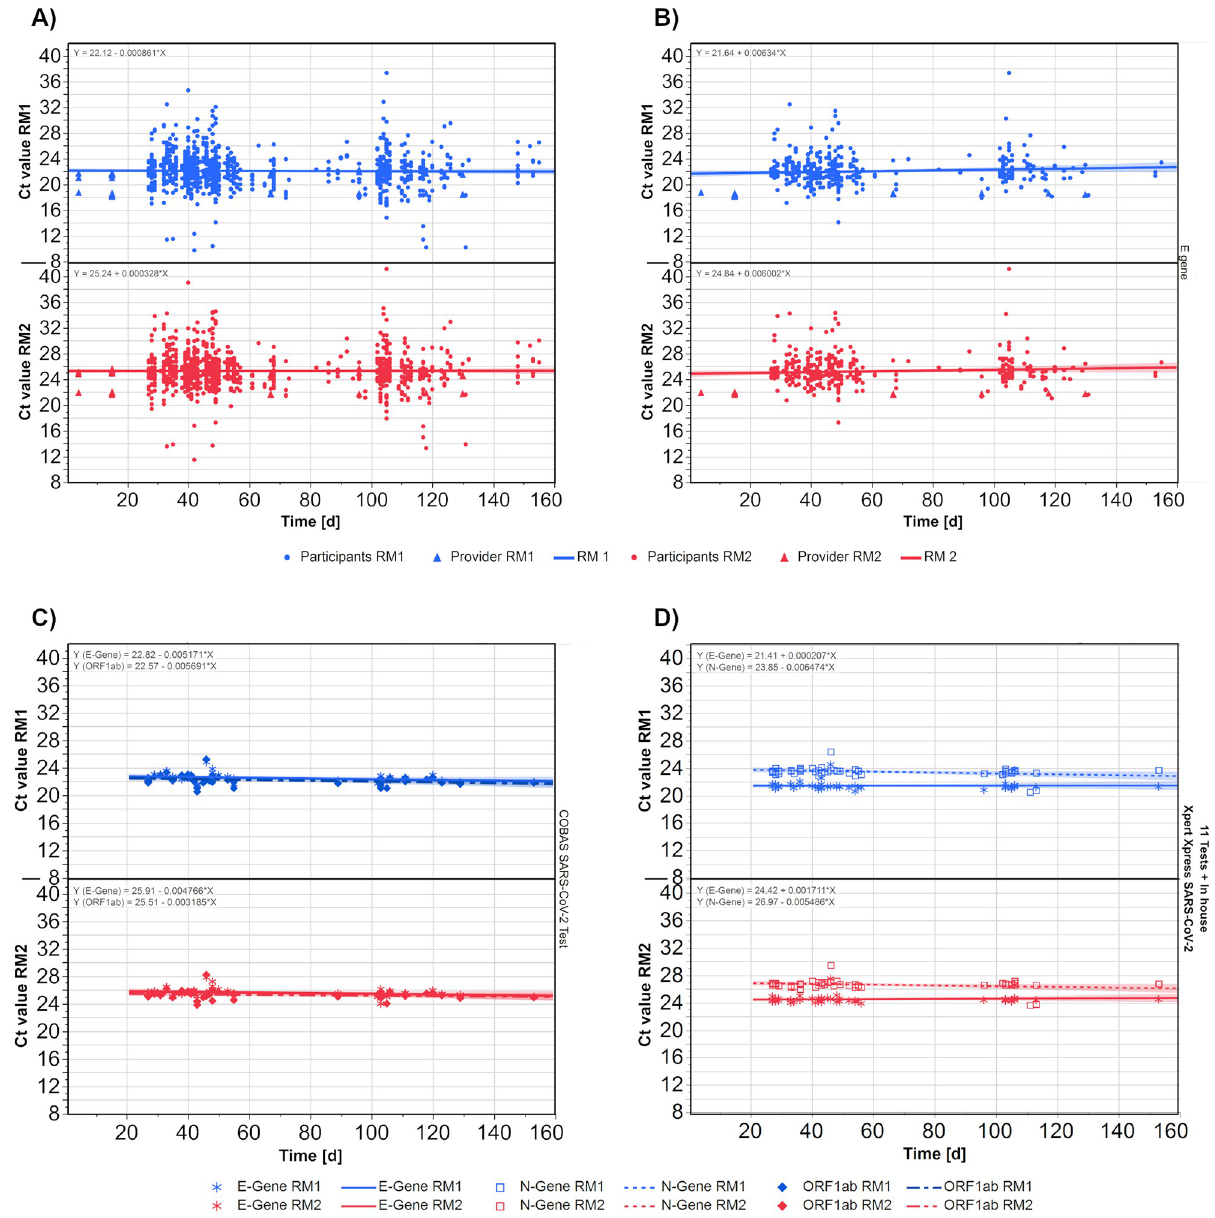
Fig 3. Development of Ct values for both reference samples over time for all results (A), just for E gene results (B), as well as all results the test system Cobas (C) and test system XpertXpress (D) for their respective gene targets. Each symbol represents one measurement. The lines represent the regression lines for the corresponding data set and the formular is displayed in the upper right corner. Dots are participants results and triangles are results from the sample provider (Figure A and B). For Figure C and D no provider results were present, so we used the asterisk for e gene result, the square for N gene results and the diamond for ORF1ab